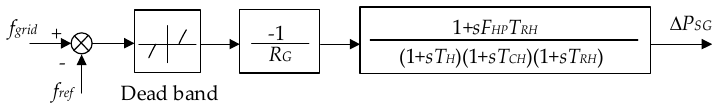
Figure 12. Structure of the steam turbine governor. Table 3. Parameters of the test system. ( a ) Parameters of the SG, ( b ) parameters of the HVDC system, and ( c ) parameters of the DFIG. System Element